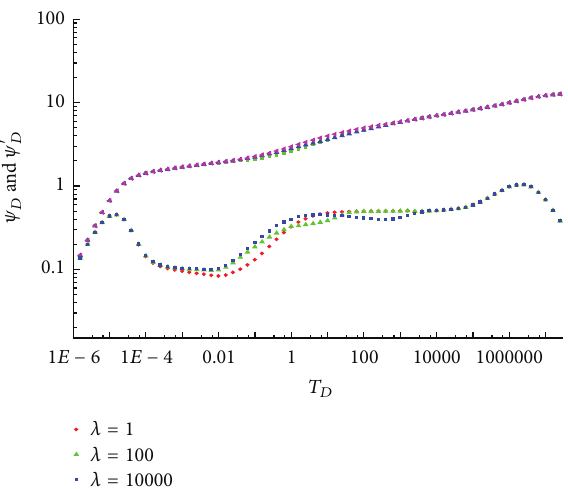
Figure 7: Influence of diffusion coefficient 𝜆 on bottom-hole pressure with mixed boundary ( 𝜔 = 0.01 , 𝛽 = 50 , 𝐿 𝐷 = 2.5 , = 0.5 , 𝐶 = 0.0001 , 𝑠 = 1 , and 𝑟 = 50 𝑍 𝑤𝑑 𝑑 𝑒𝐷